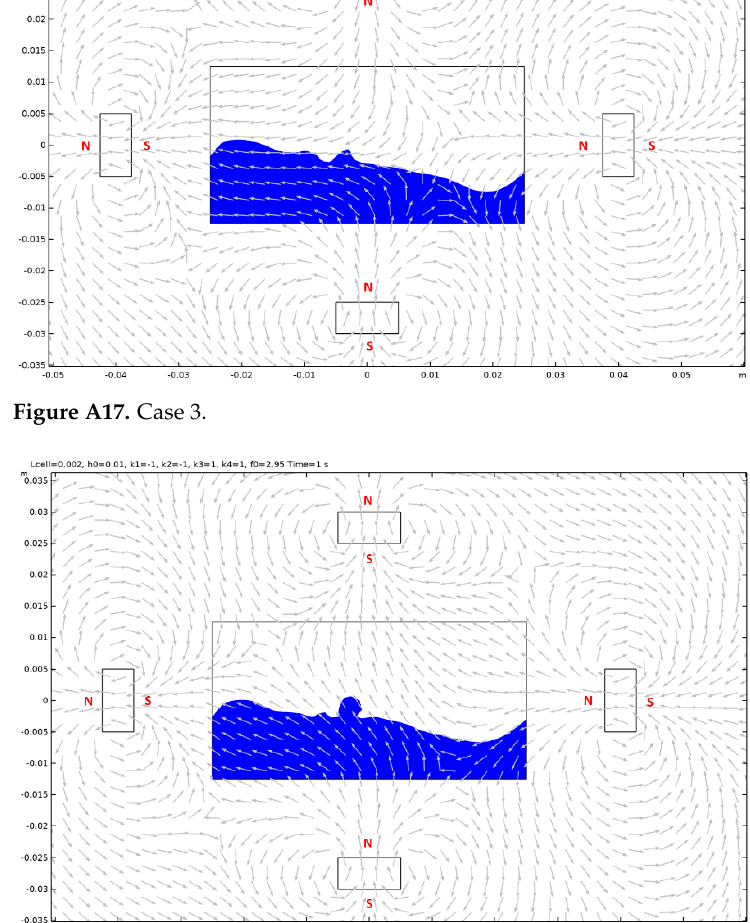
Figure A18. Case Figure A18. Case 4. Figure A18. Case 4.